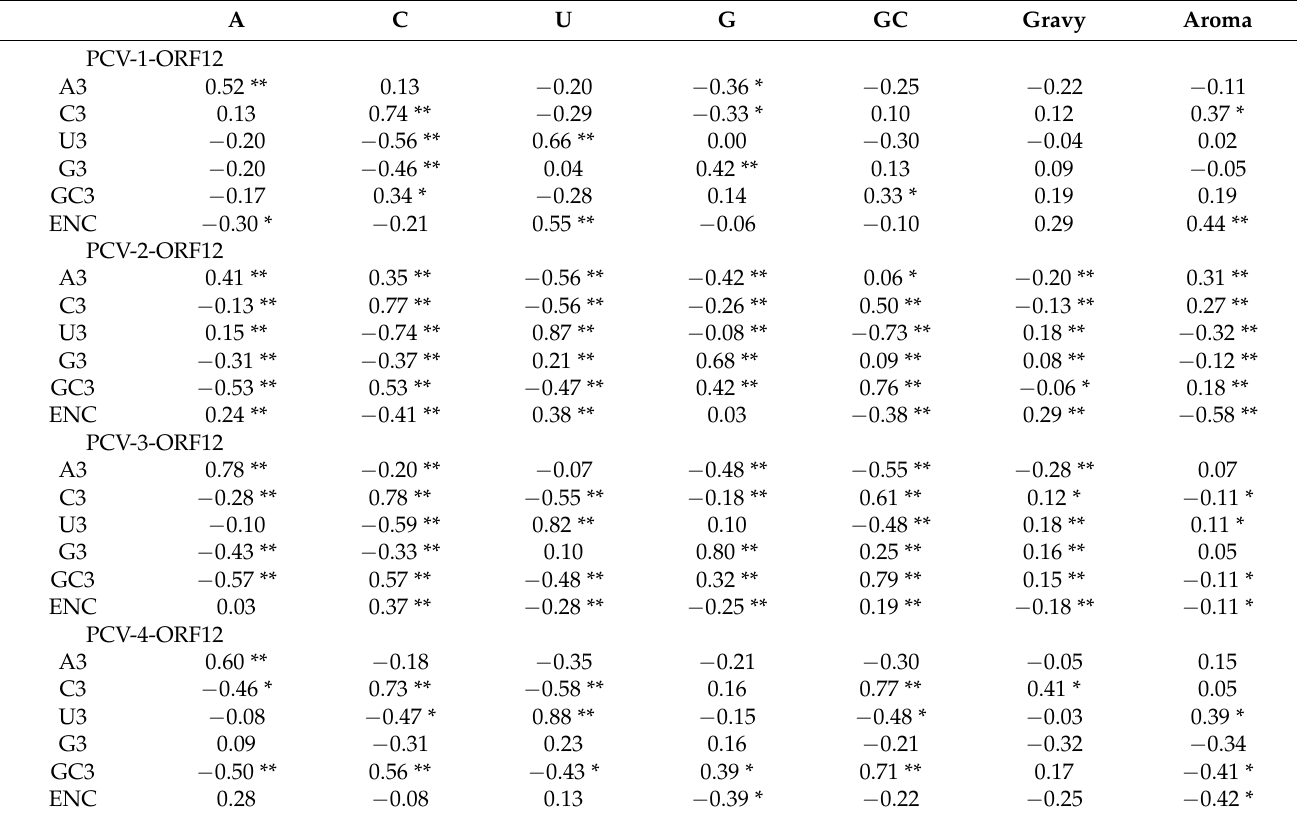
Table 4. The correlation between the content of A3, T3, G3, C3, GC3, ENC and A%, T, G, C, GC, Gravy values, Aroma values for each PCV genotype. (r values were shown in the